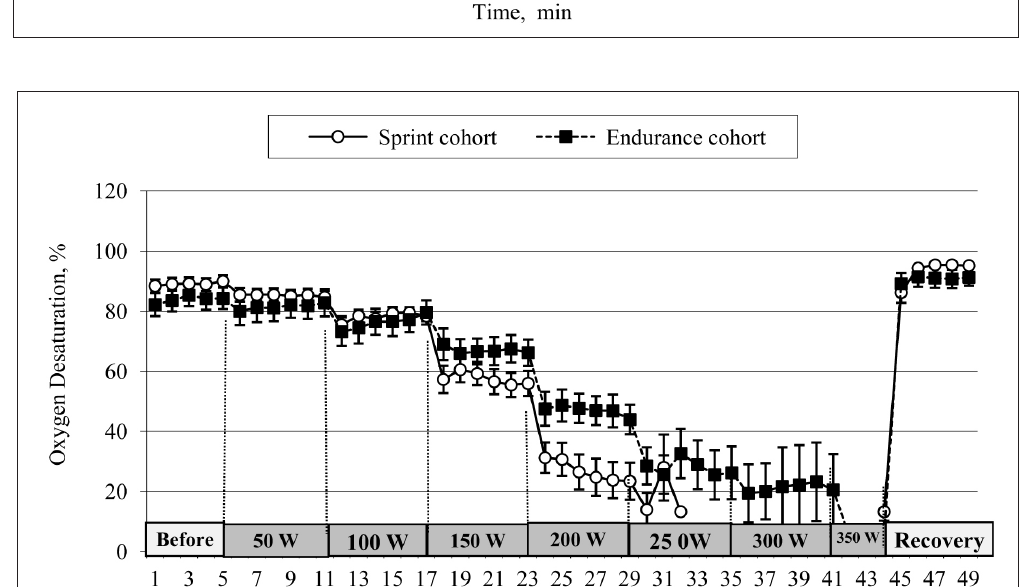
Figure 2. Dy - namics of oxy - gen desatura - tion (StO 2 ) du- ring the incre - mental increase in